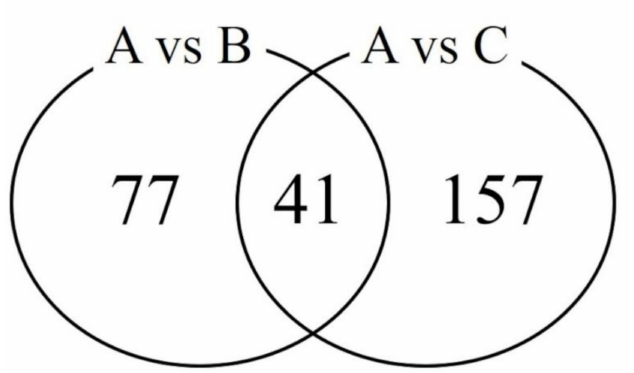
Figure 2. Number of differentially expressed genes in the β -alanine or L-histidine supplementation group compared to the non-supplemented group. A, B, and C represent the non-supplemented group, the β -alanine supplementation group, and the L-histidine supplementation group, respectively.